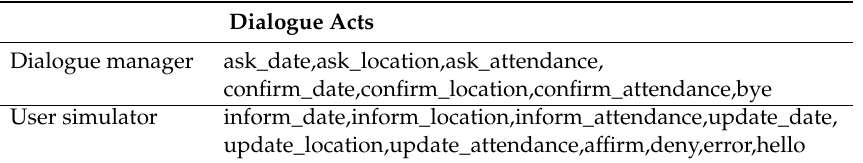
Table 1. lists all dialogue acts in